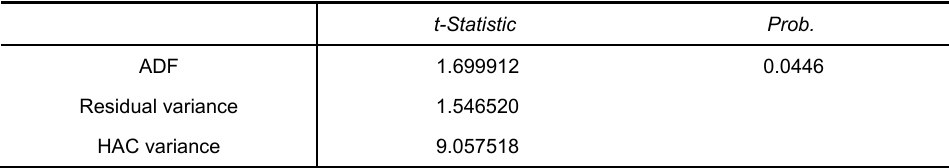
t-Statistic Prob.